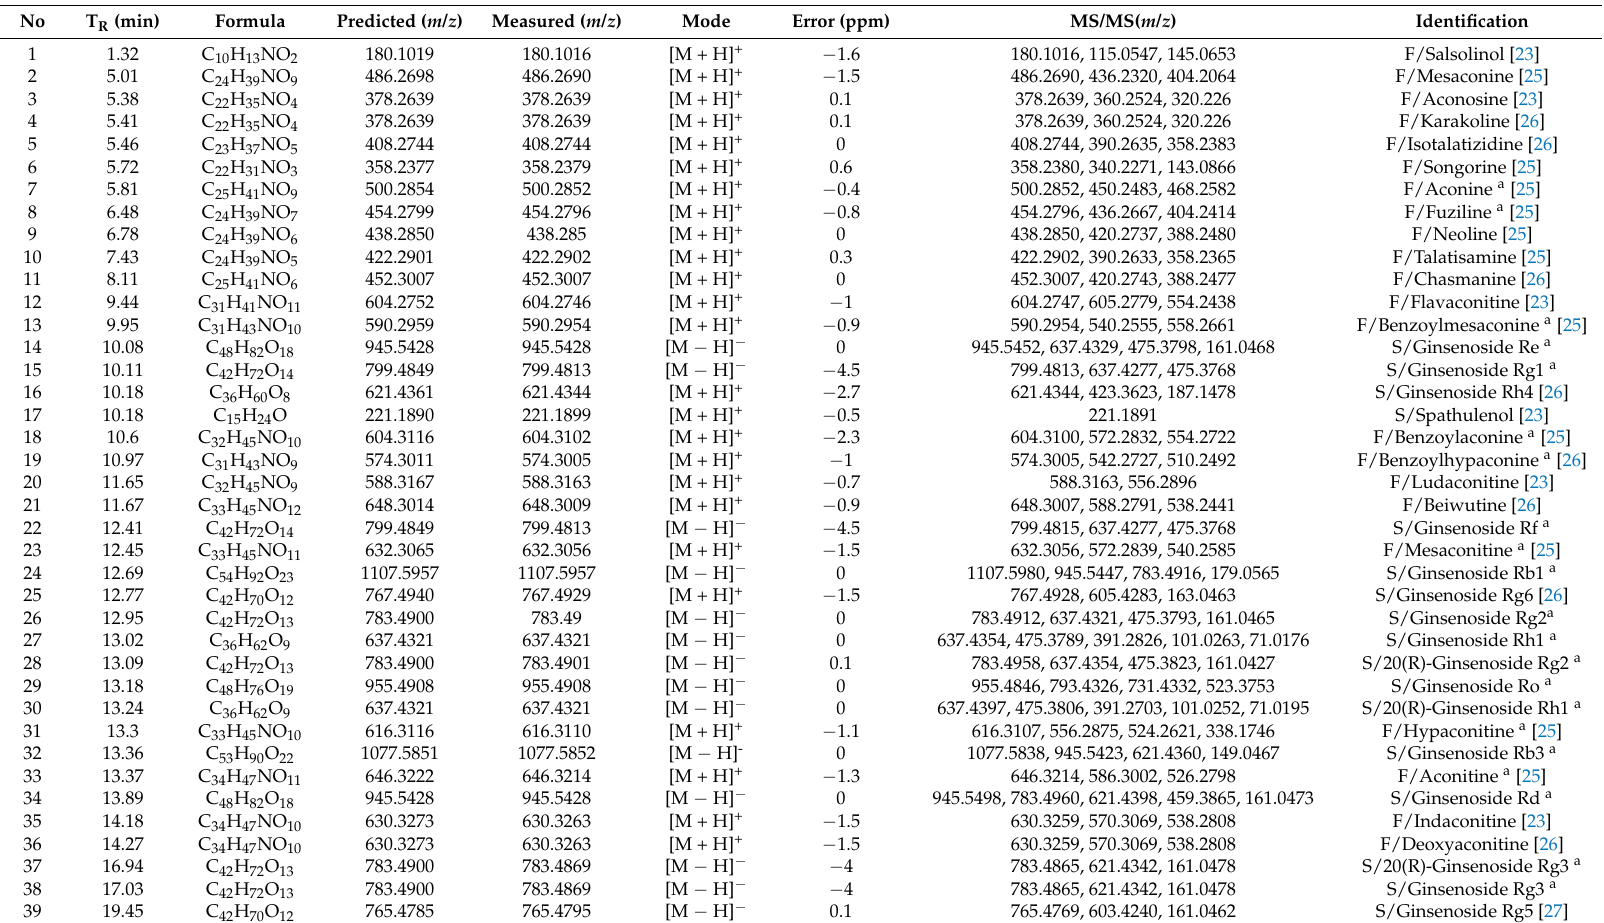
Table 1. Identification of major compounds in SFPD by